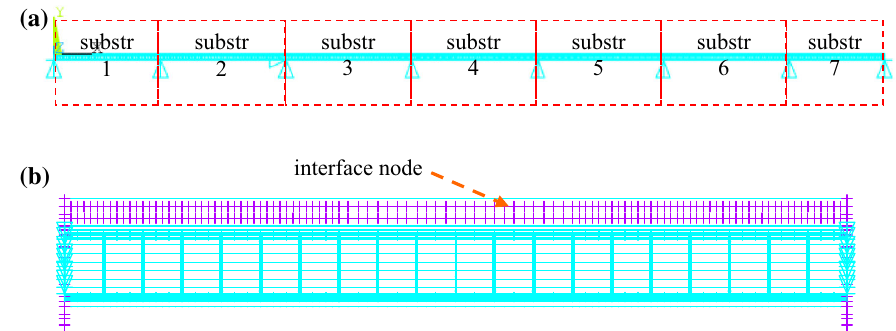
interface nodes of the composite box girder bridge: a vertical view and b plan view of substructure 4 with interface